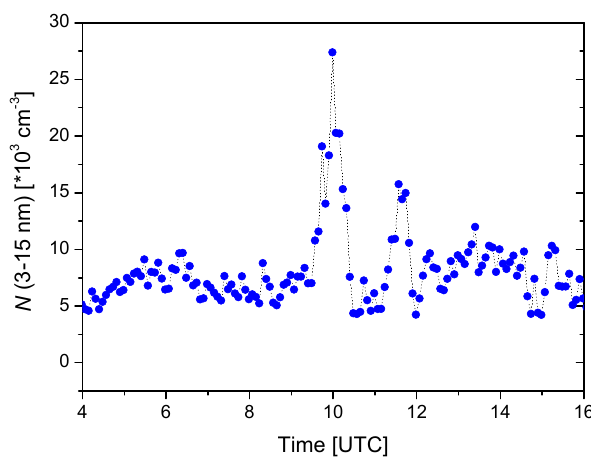
Fig. 9. Diurnal variation of number concentration of total particles in the size range 3–15nm measured with the NAIS on 13 May 2008 at Cabauw. The measurements were taken in a height of 60m above ground at the Cabauw